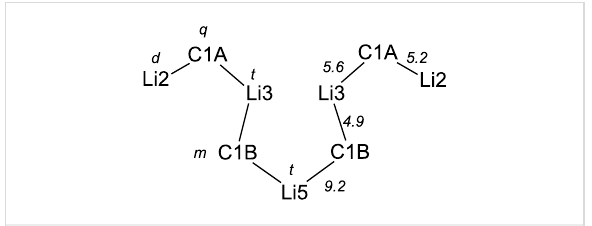
Figure 4: C 2 Symmetric carbon–lithium chain of 2a - I in THF, showing the carbon–lithium connectivities, multiplicities of the NMR signals (left), and magnitudes of 1 J ( 6 Li, 13 C) couplings in Hz (right) [15].